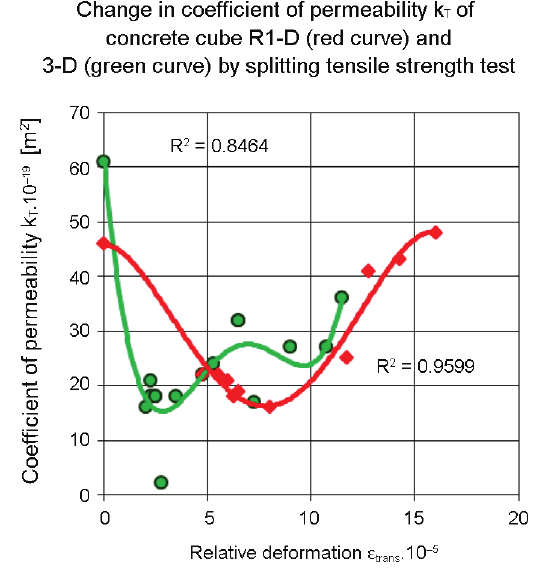
Fig. 9. Dependence of k T /ĺ trans for concrete cube R1-D and 3-D